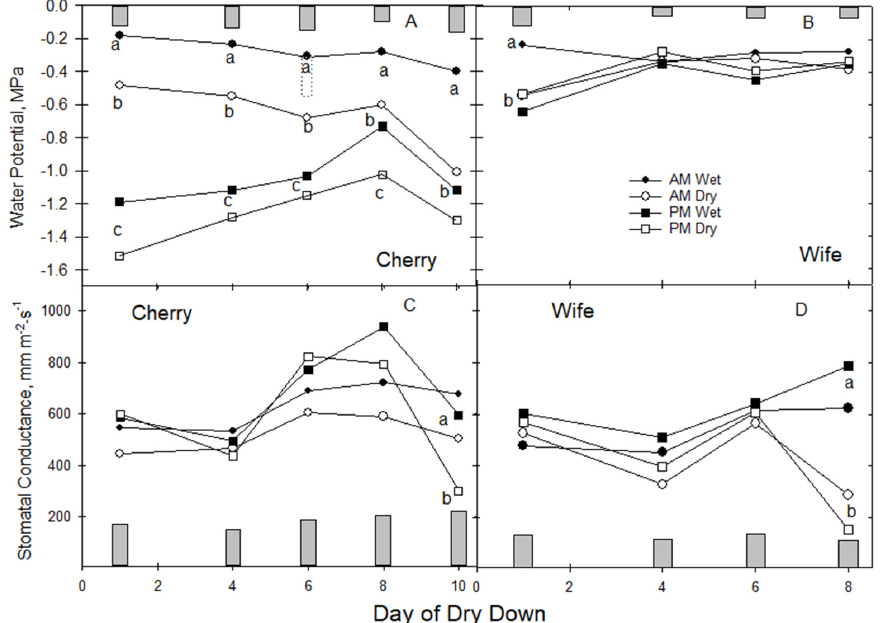
Figure 2. Preliminary dawn-to-dusk water relations study showing: graphs ( A ) and ( B ) predawn (AM) and midafternoon (PM) leaf water potential for the hemp cultivars ‘Cherry’ and ‘Wife’, respectively; graphs ( C ) and ( D ) predawn (AM) and mid-afternoon (PM) stomatal conductance for water-stressed and well-watered hemp varieties ‘Cherry’ and ‘Wife’. Bars along the X -axis of each graph are pooled standard deviation across treatment and cultivar for each measurement day ( n = 16). Data points within a day separated by di ff erent le tt ers are signi fi cant at p < 0.05 using Tukey’s posthoc HSD test ( n = 4).